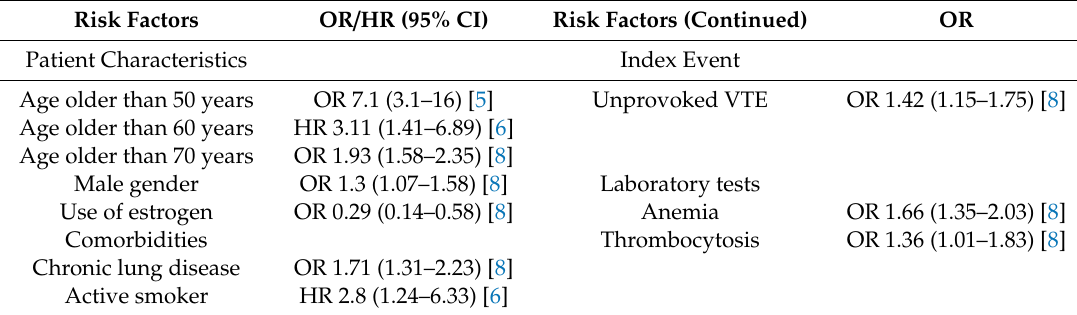
Table 1. Suggested risk factors 1